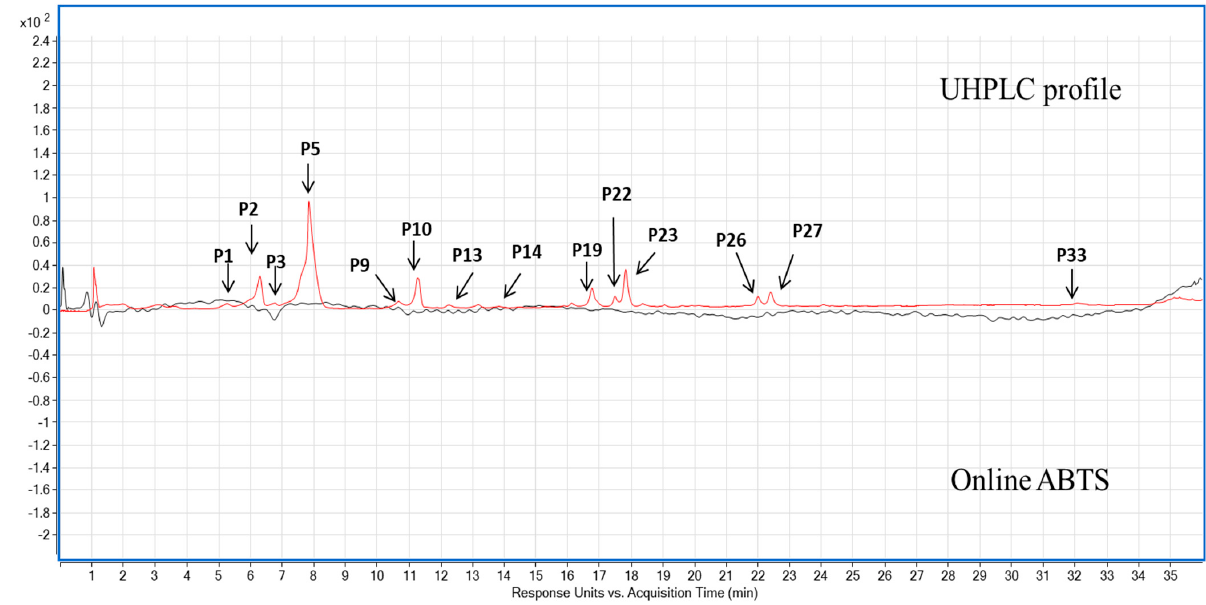
ABTS antioxidant activity profile at 414 nm.